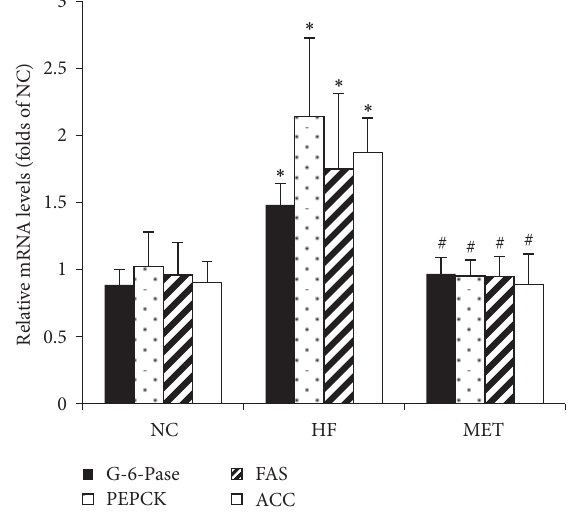
Figure 1: The mRNA expression of the key enzymes regulating gluconeogenesis and fatty acid synthesis in the liver. SD rats were fed a normal chow diet (NC group, 𝑛 = 6 ) or a high fat diet ( 𝑛 = 12 ) for 15 weeks; then the high-fat-diet rats were gavaged saline (HF group, 𝑛 = 6 ) or metformin 400mg/kg/d (MET group, 𝑛 = 6 ) for 4 weeks. ∗ 𝑃 < 0.05 , compared with NC group. # 𝑃 < 0.05 , compared with HF